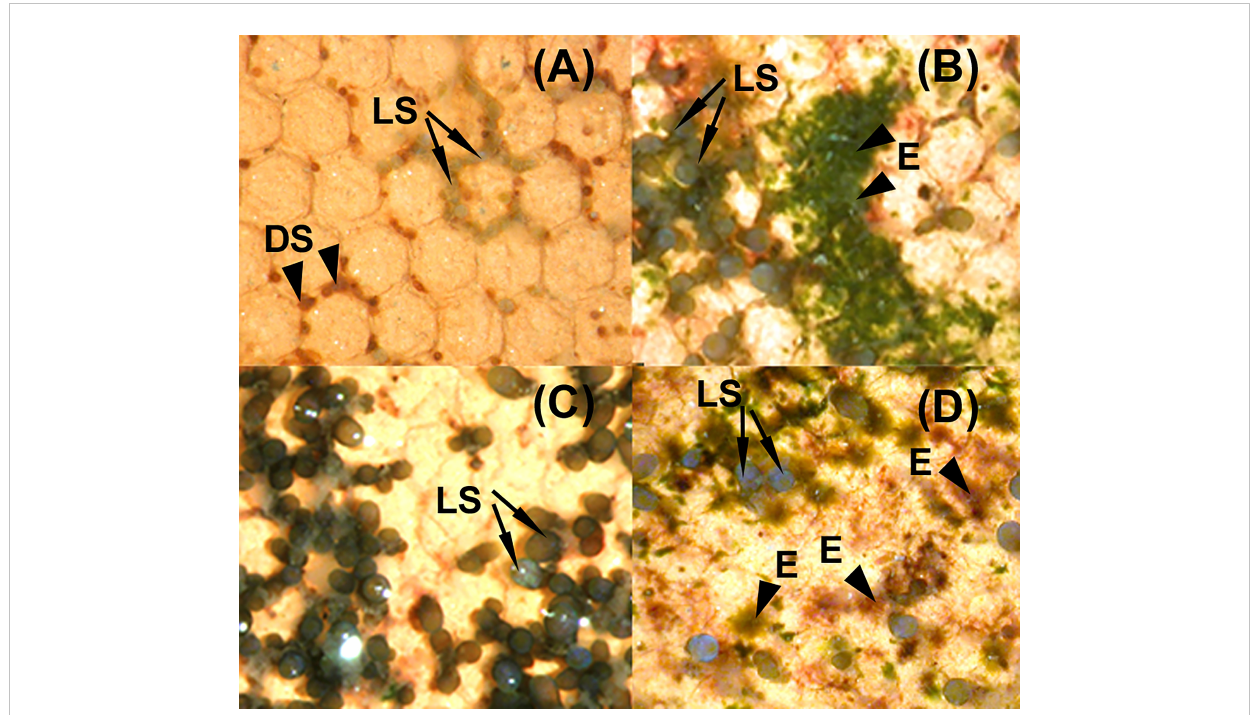
FIGURE 4 Clay tiles with Ericaria amentacea seedlings at the end of the laboratory culture (T3) under different culture media: (A) C (seawater, SW) with living seedlings (LS, arrows) and dead seedlings (DS, arrowheads). (B) VS (SW with addition of von Stoch) with living seedlings (LS, arrows) and epiphytes (E, arrowheads). (C) A2 (SW with Algatron 4.5 mL L -1 ) with living seedlings (LS, arrows). (D) VSA (SW with addition of von Stoch and Algatron 4.5 mL L -1 ) with living seedlings (LS, arrows) and epiphytes (E, arrowheads).